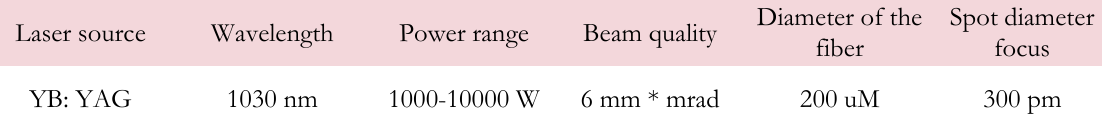
Table 2: Features of the laser source.